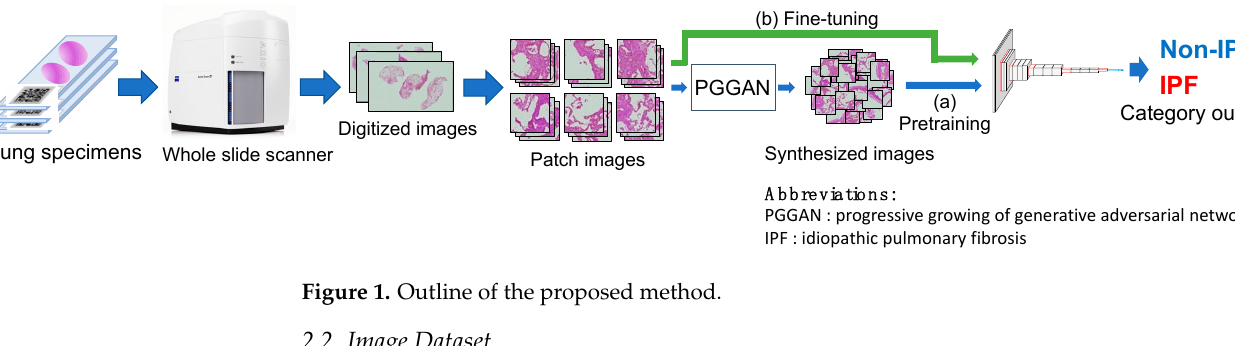
Figure 1. Outline of the proposed method.